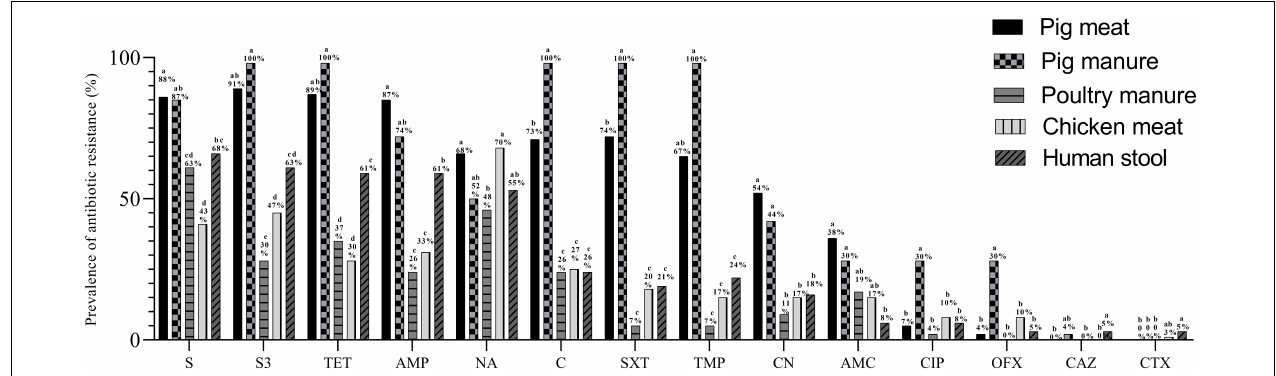
FIGURE 4 | Prevalence of antibiotic resistance among Salmonella Typhimurium isolates from pig meat, pig manure, poultry manure, chicken meat, and human stool. Different lowercase letters indicate statistically significant differences between groups ( P < 0.05).